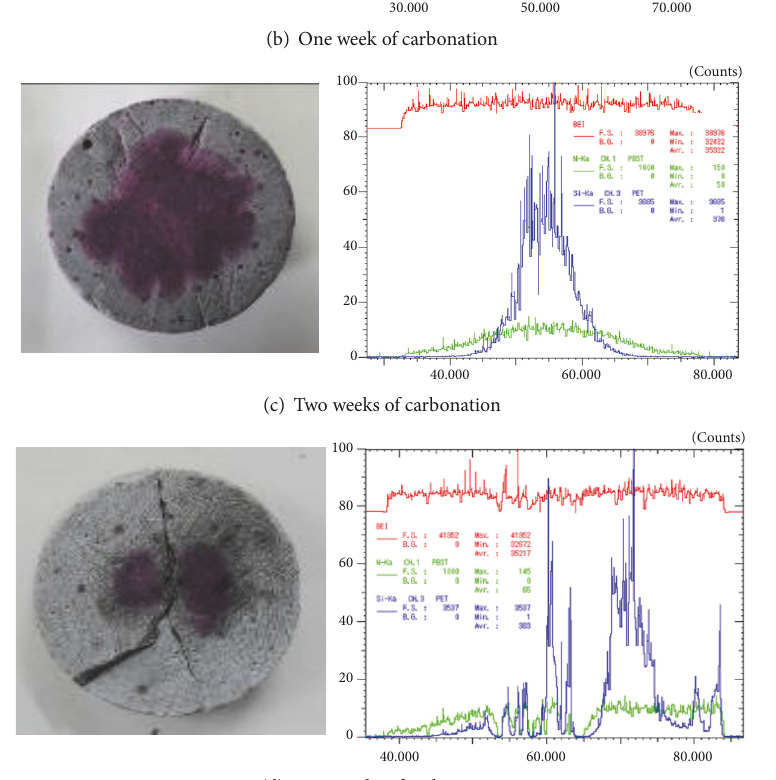
Figure 4: Distribution of N elements after